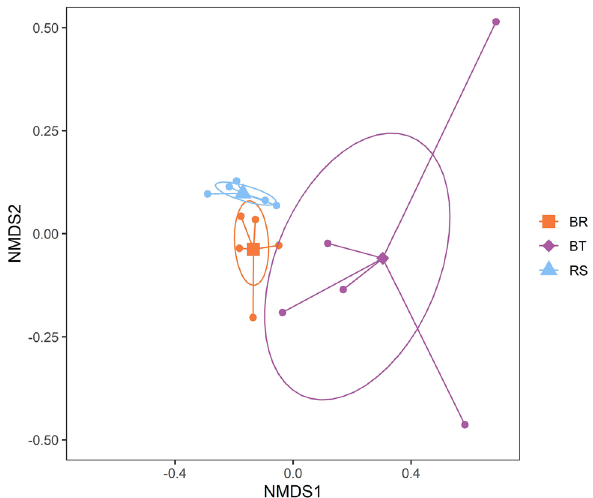
Figure 3. Compared community composition of endophytic bacterial communities in field-collected leaf samples from the association between the model tree Rhaphithamnus spinosus and the mimetic vine Boquila trifoliolata . Groups: RS = leaves from R. spinosus [centroid: sky blue triangle], BR = Boquila leaves mimicking the tree leaves [centroid: orange square], and BT = Boquila leaves from the same individual vine but not mimicking the tree leaves [centroid: purple rhombus]. Patterns are based on a two-dimensional non-metric multidimensional scaling (NMDS) analysis (final stress = 0.063). Standard error ellipses show 95% confidence